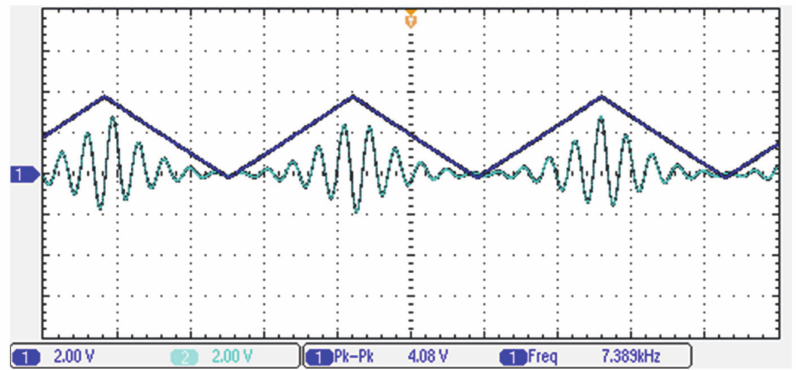
Figure 31. The measurement result of the AM signal generator using triangle wave input signal.